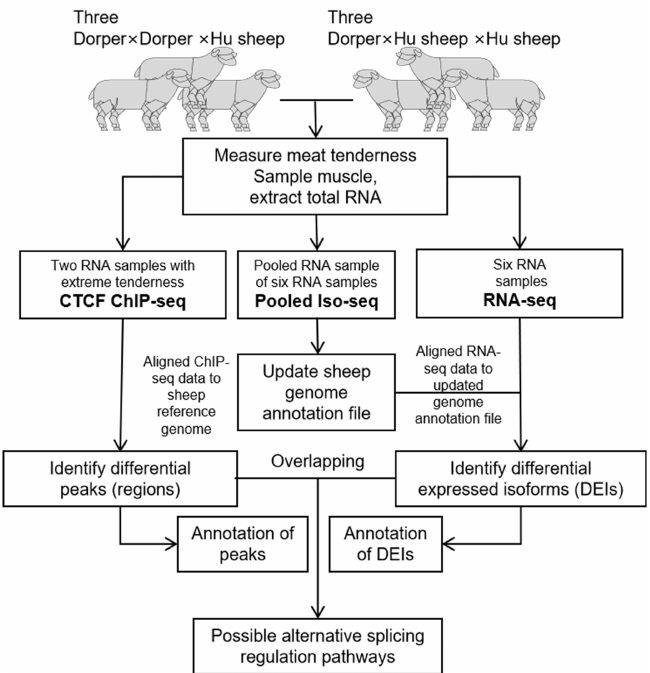
Figure 1. The overall experimental design. DEIs, differentially expressed isoforms.